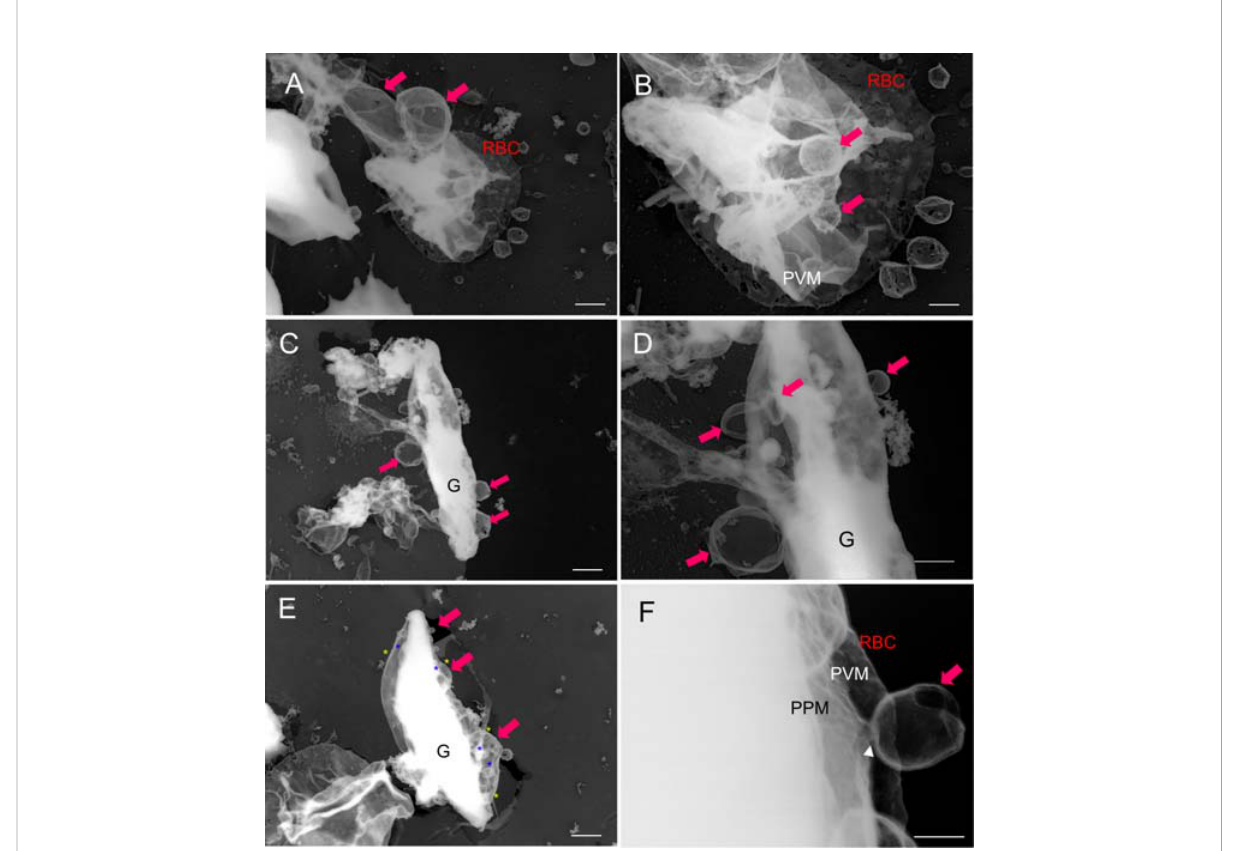
FIGURE 6 Budding pouches were revealed via TEM analysis of unroofed structures (A – F) Large membrane ( “ pouch ” ) budding from the PVM or parasite body (pink arrow). (D) The membrane whorls (that were also observed in b, and e) are marked by yellow asterisks (outer membranes) and blue asterisks (inner membranes). (F) An enlarged view of d. TEM, transmission electron microscopy; PVM, parasitophorous vacuole membrane; PPM, parasite plasma membrane; G, gametocytes. Bar = 1 µm (A, C, E), 500 nm (B, D) , 100 nm (F)